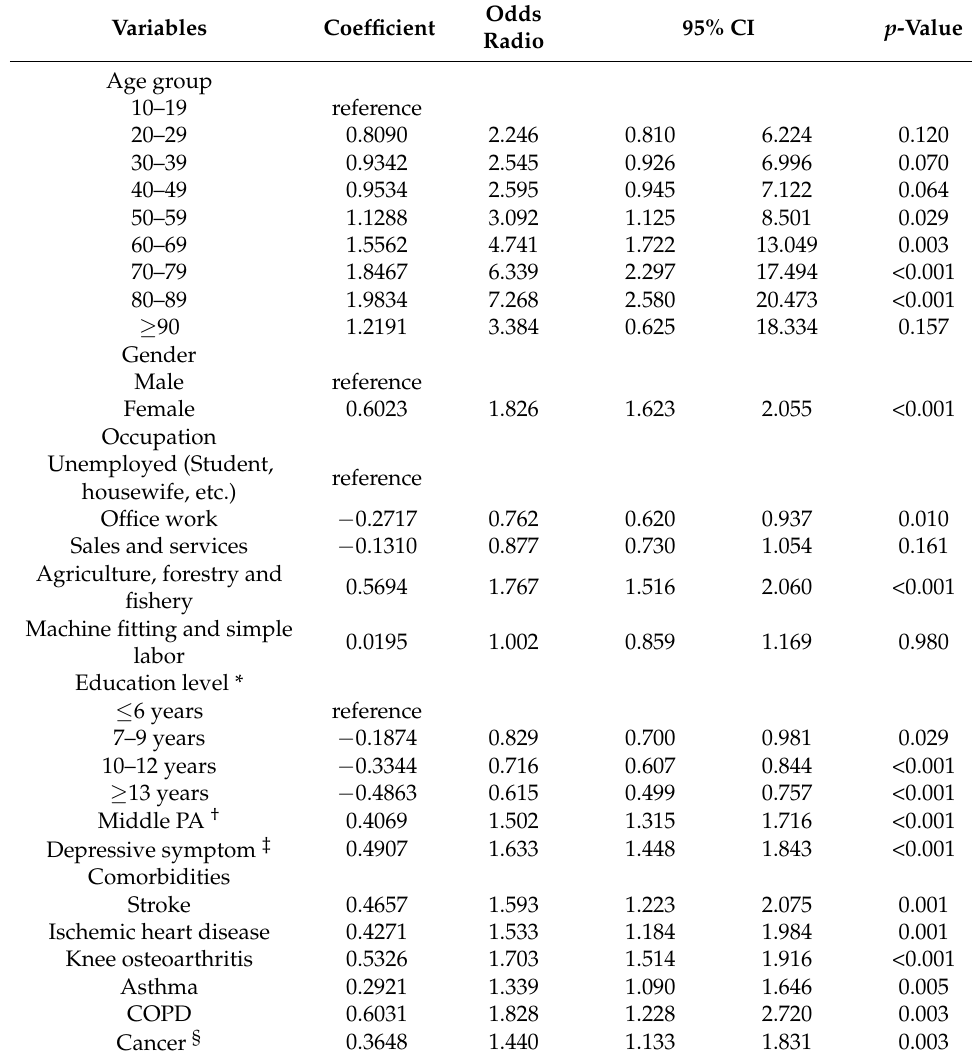
Table 2. Chronic low back pain risk prediction model using multiple logistic regression in develop- ment